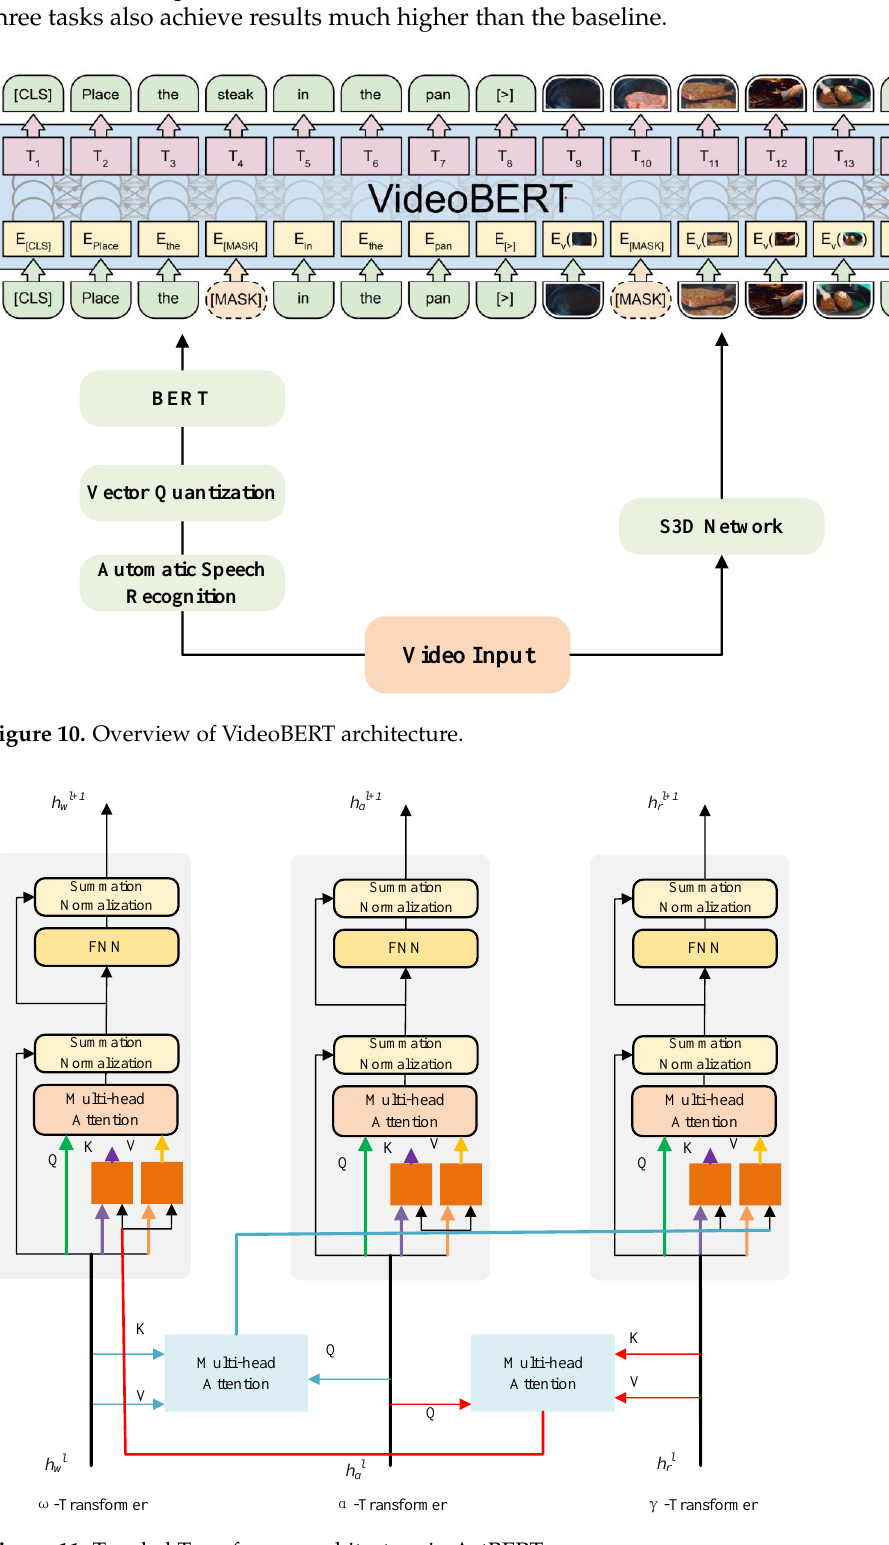
Figure 11. Tangled Transformer architecture in